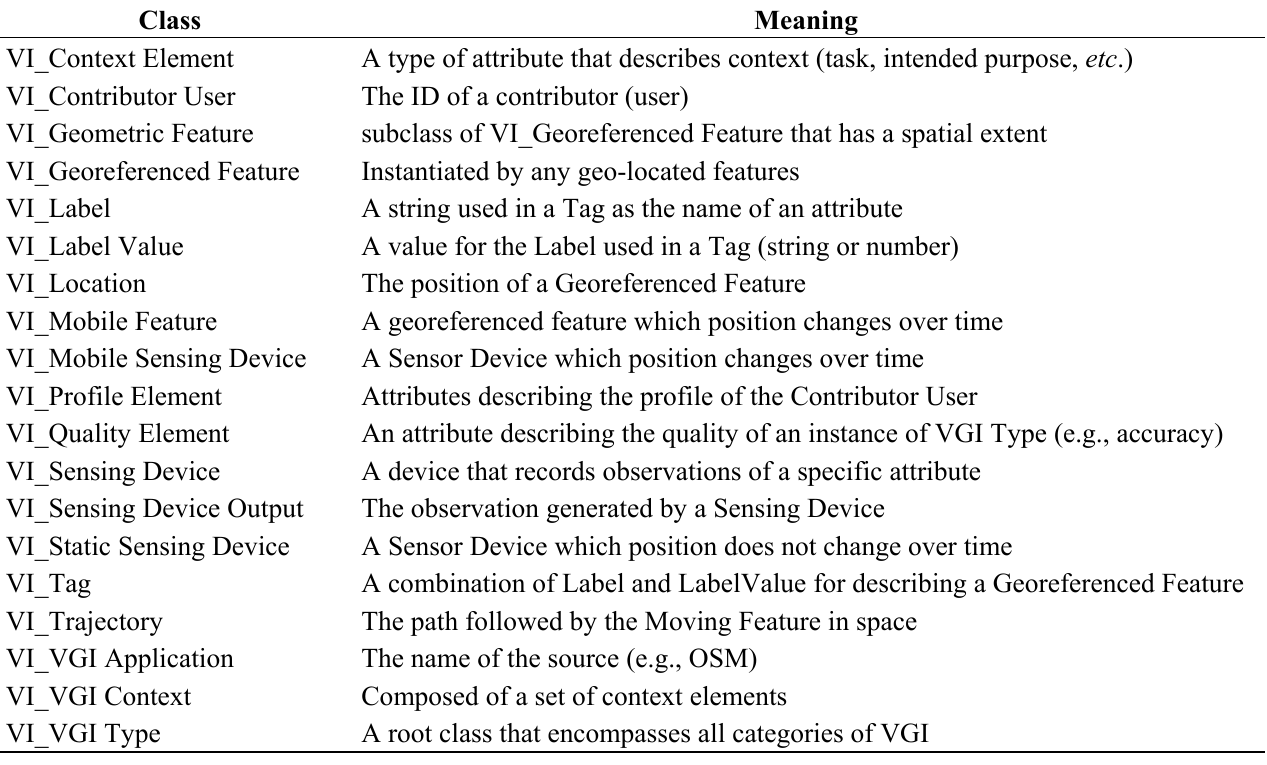
Table 2. Meaning of the classes of the VGI Semantic